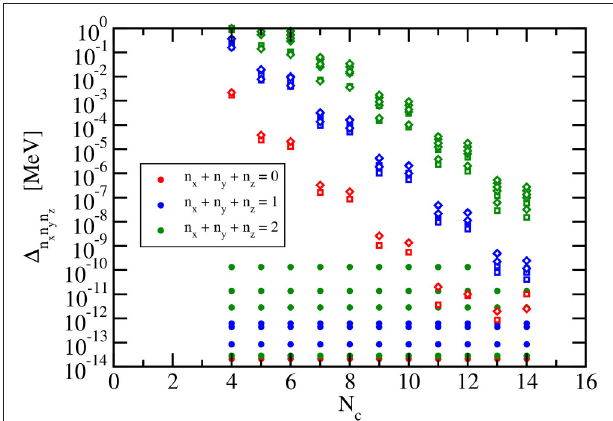
FIGURE 5 | Deviation (88) of the calculated lowest energies of a relativistic h ω harmonic oscillator with 20 MeV and m 938 MeV/ c 2 from the exact = = ¯ results for constant scaling factor ( h 0.1 fm) and constant number of grid = points ( N 25). Results are shown as a function of the number of channels N c = for the spherical case (full symbols), prolate deformation with d 0.1 (open = diamonds), and oblate deformation with d 0.1 (open = −